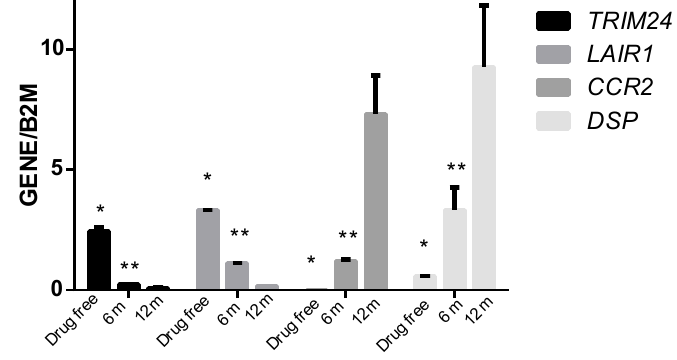
Figure 5. Normalized mRNA levels of the genes TRIM24 , LAIR1 , CCR2 and DSP in the drug-free stage and after 6 and 12 months of VPA treatment in pediatric patients with epilepsy. The gene levels were normalized to the level of the housekeeping gene B2M and are expressed per 20 ng of total RNA. The values represent the means with standard deviations (SD) of the expression levels of each gene. * p < 0.05 vs. the level of gene expression after 6 and 12 months of VPA treatment, and ** p < 0.05 vs. the levels of gene expression after 12 months of VPA treatment. In addition to the genes that increased during epilepsy and without treatment, we found that the expression of 243 genes of the 637 genes with significant expression in epileptic children before